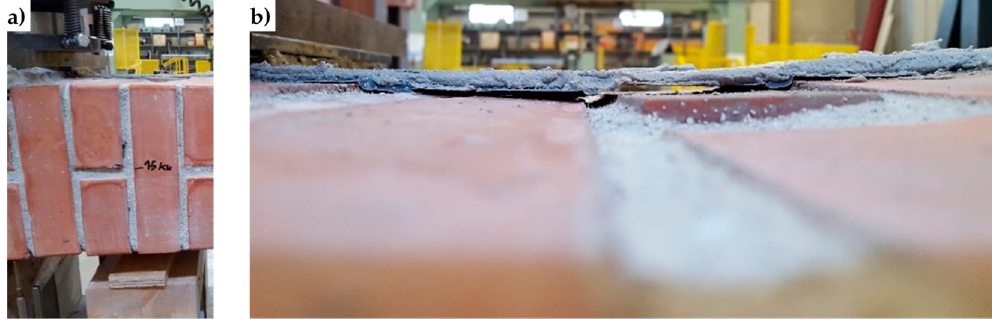
Figure 44. Delamination of the compressed CFRP strip: ( a ) length of the crack for the delamination load on the compressed side (15 kN) and ( b ) detail of delamination, just above the crack.